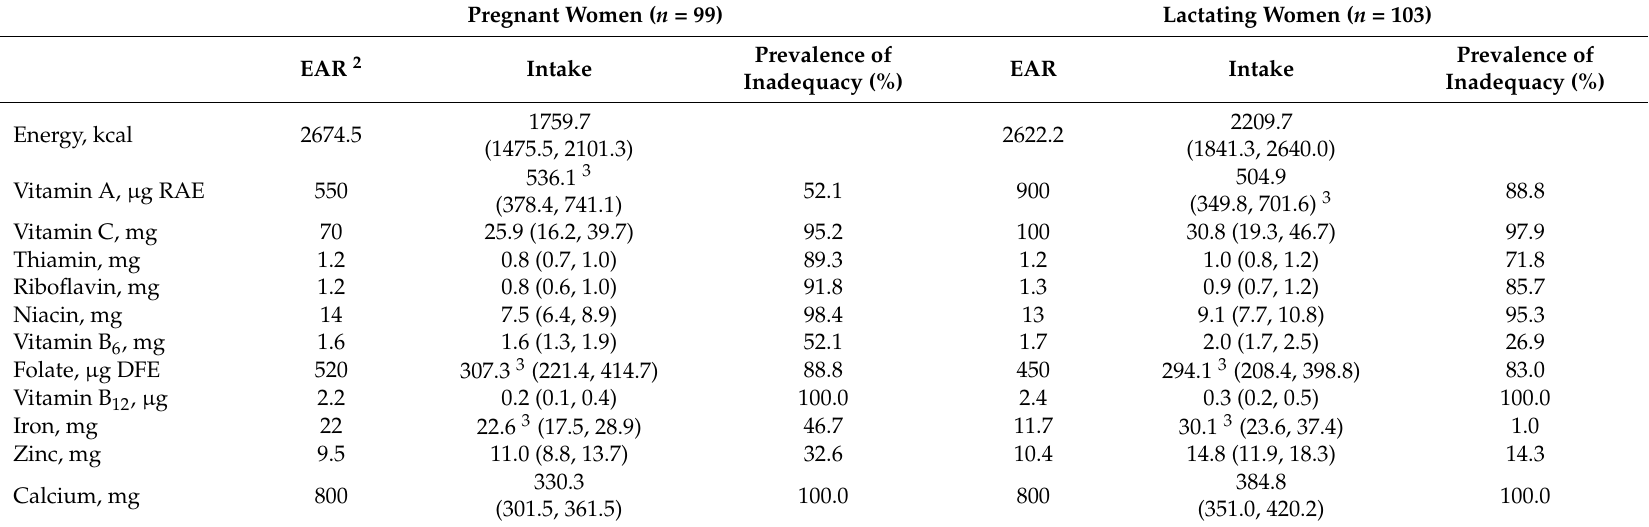
Table 3. Median (IQR) usual daily dietary intakes of macro- and micronutrients from foods among pregnant and lactating women and prevalence of inadequate micronutrient intakes 1